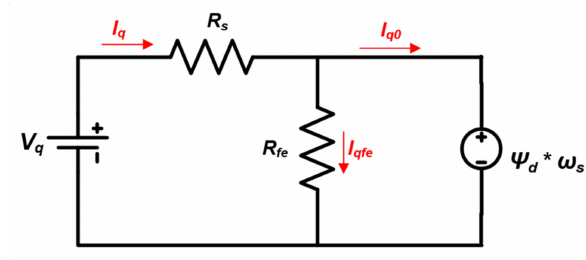
Figure 3. q–axis equivalent